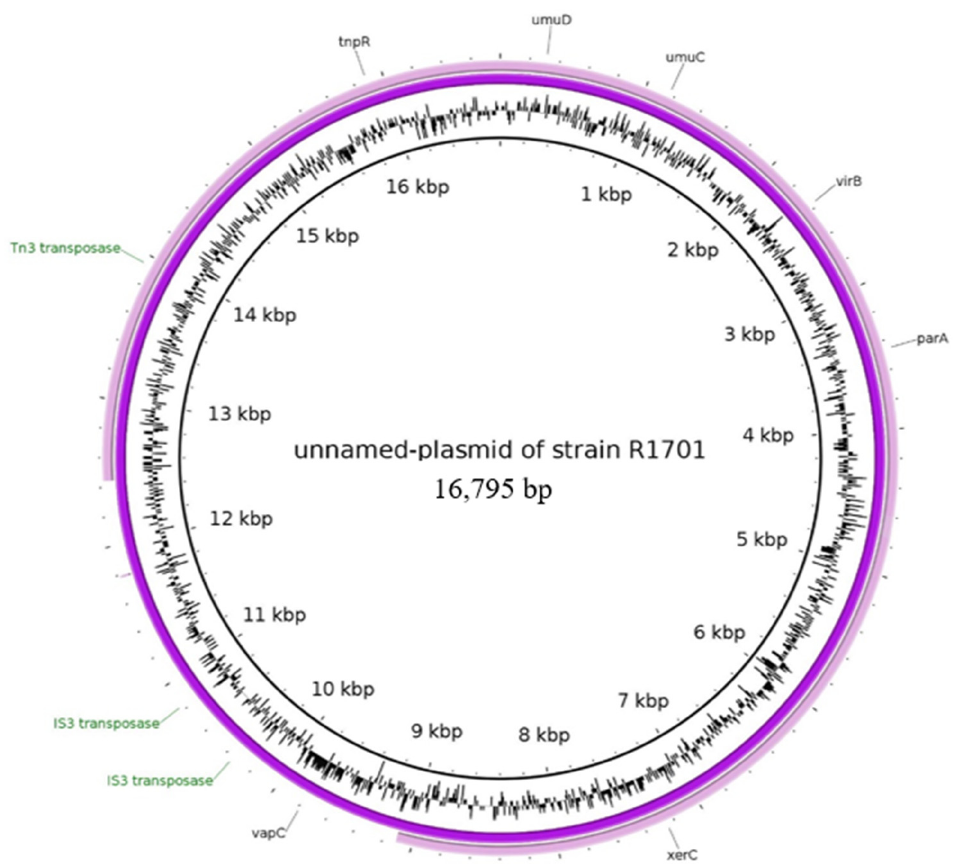
Figure 4. BRIG image of sequence contigs of individual isolates assigned to the unnamed reference plasmid (NZ_CP039972). Contigs belonging to the isolates as follows (from inner to outer ring): unnamed reference plasmid of the strain R1701 and 17-AB01531.